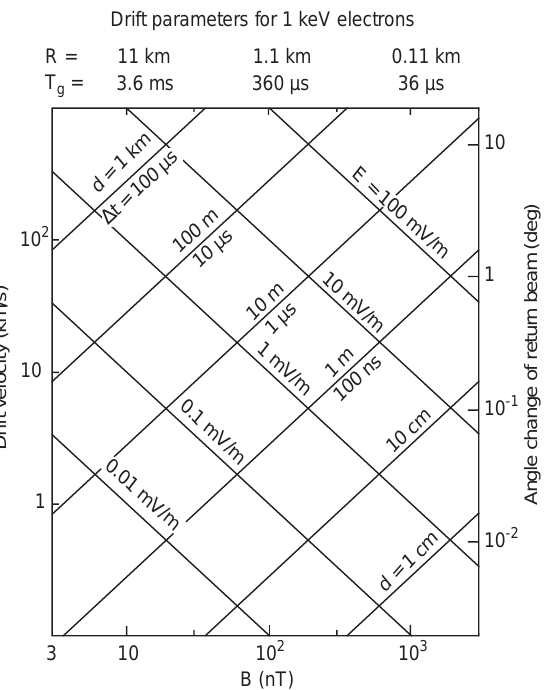
Fig. 2. Key parameters for the EDI technique for 1 keV electrons, plotted versus magnetic field B and the E · B drift velocity. Lines of constant drift-step d and electric field E are